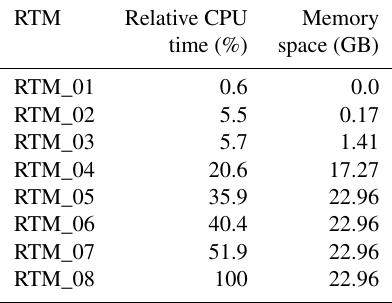
Table 2. The computational resources requirement of the RTMs used in the SPM for the realistic urban configuration. The CPU time is given relative to the CPU time of RTM_08 (3422min, ex- cluding the initialization, restart, and post-processing phases). Note that the RTM requires < 5% of total runtime of the model run with RTM_08. The memory space is given for the essential fields only.